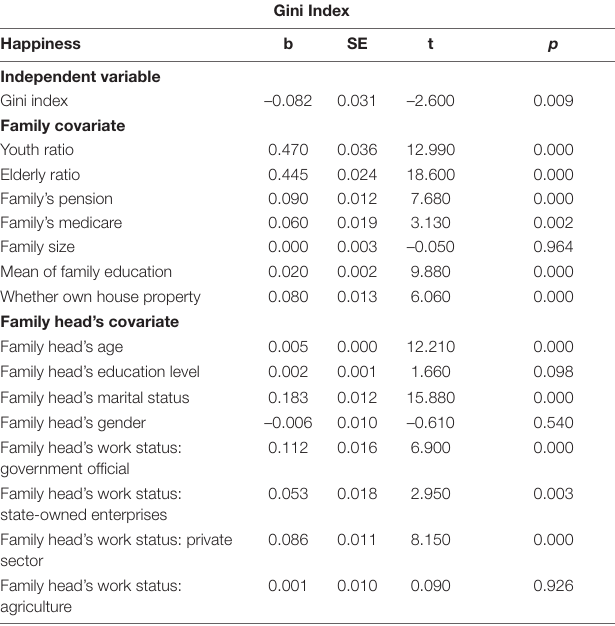
TABLE 3 | OLS regression on the relationship between happiness and wealth